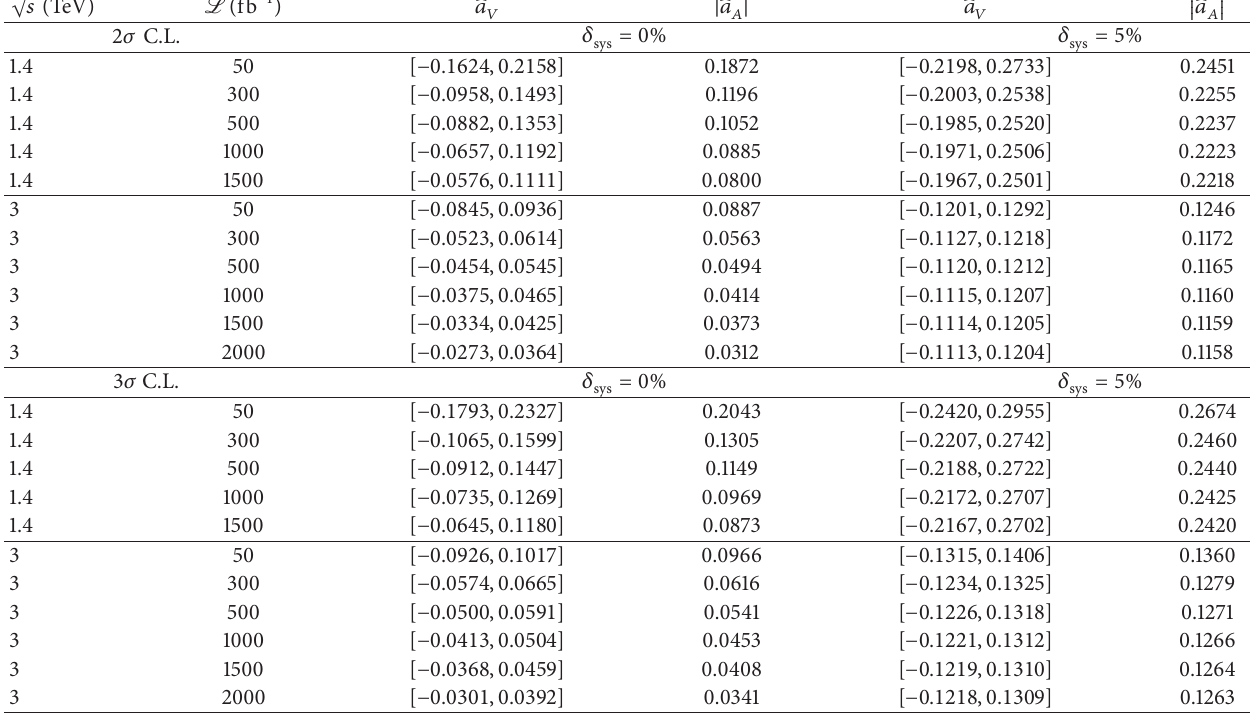
Table 2: Bounds on the ̂𝑎 𝑉 magnetic moment and ̂𝑎 𝐴 electric dipole moment for the process 𝛾𝑒 − → 𝑡𝑏 ] 𝑒 ( 𝛾 is the Compton backscattering photon) for 𝑏 -tagging efficiency = 0.8 , 𝛿 sys = 0 %, 5 % at 2𝜎 and 3𝜎